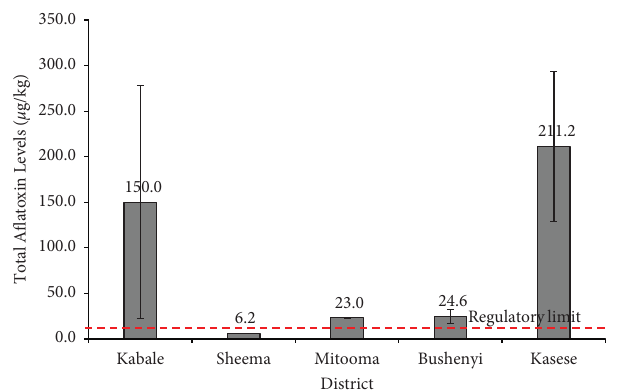
Figure 1: Total afatoxin levels in groundnut four samples (the regulatory limit for E. Africa is in broken lines).